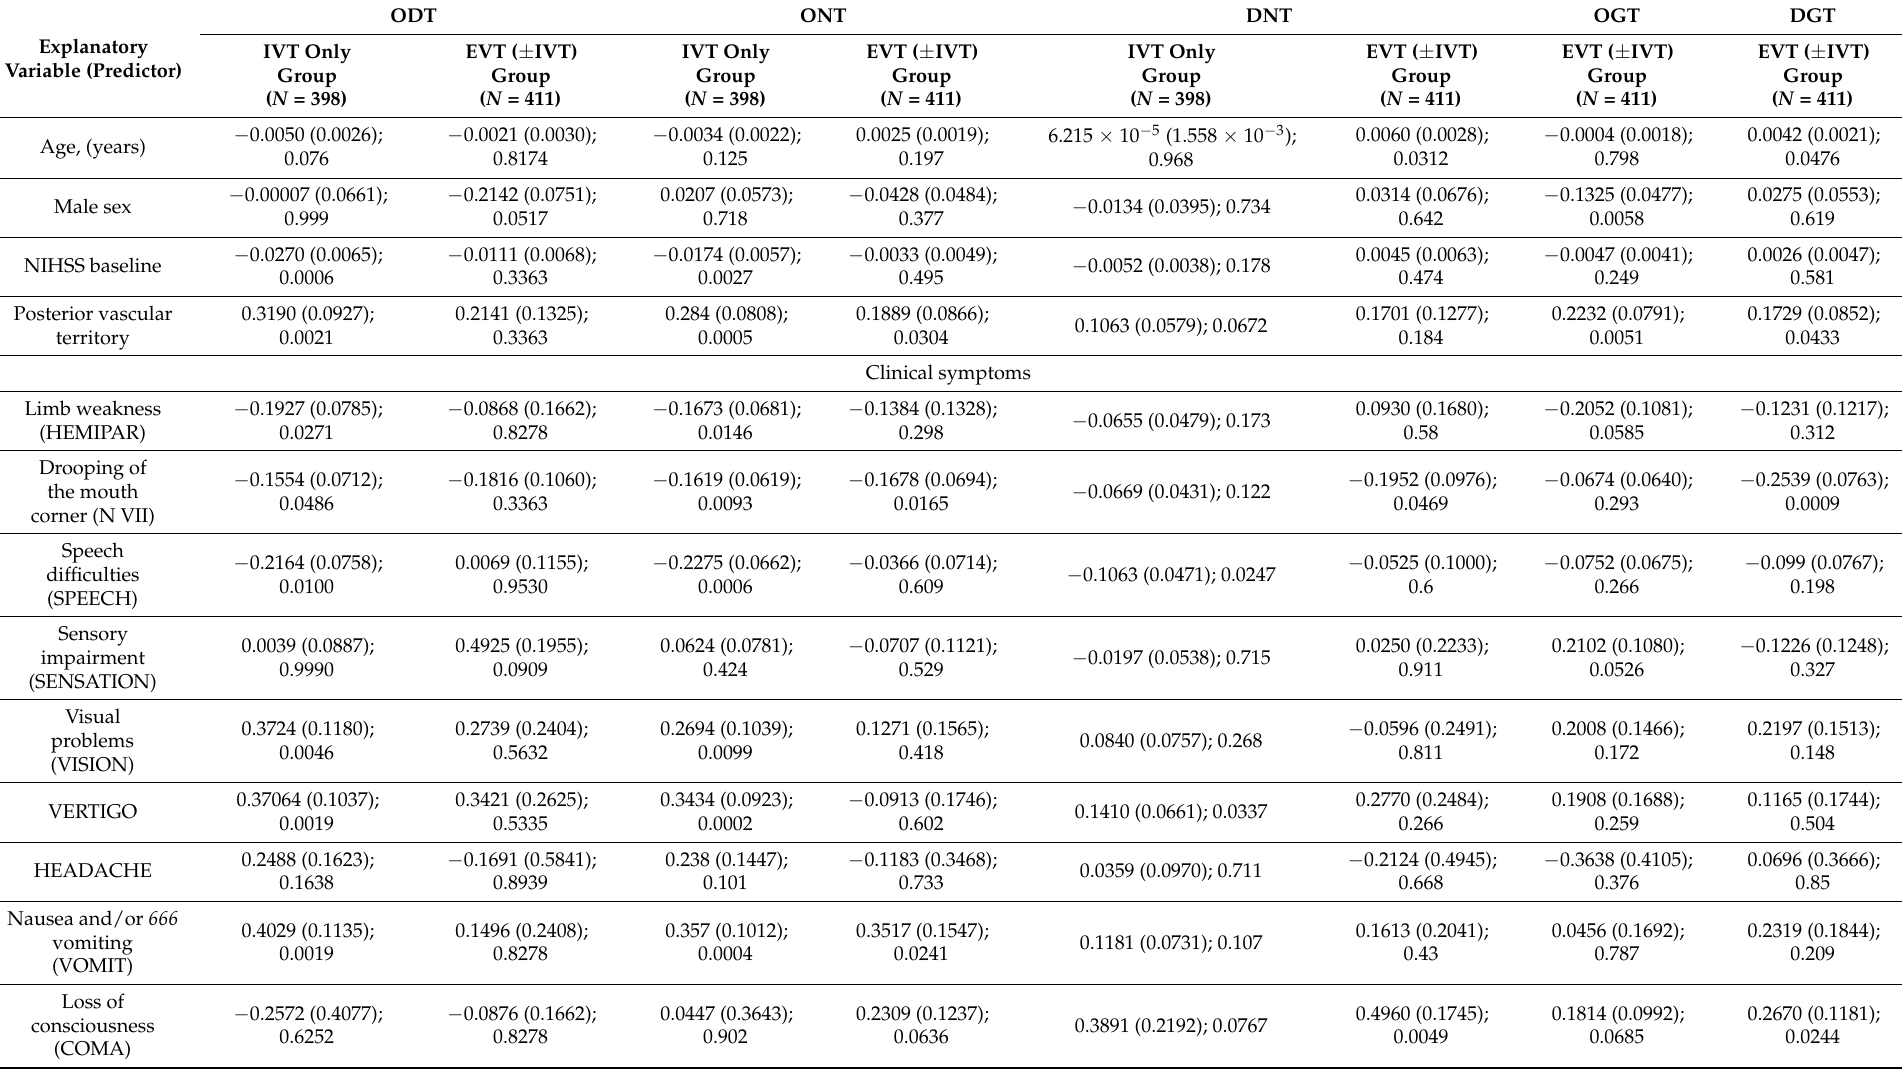
Table 3. Univariate regression analysis of the dependency of recanalization